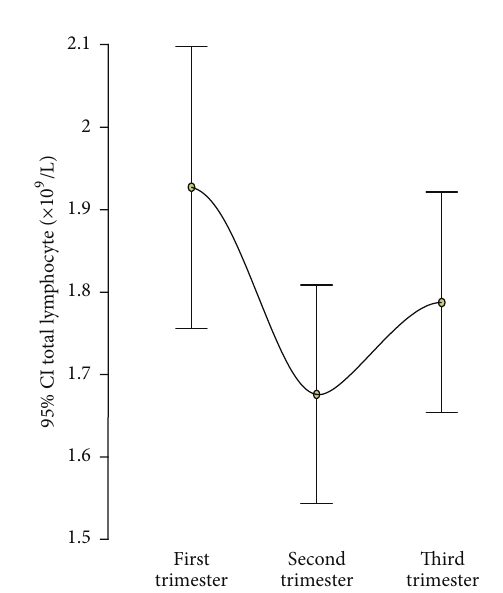
Figure 2: Error bar plot of the mean and 95% confidence interval of total lymphocyte count in each trimester of